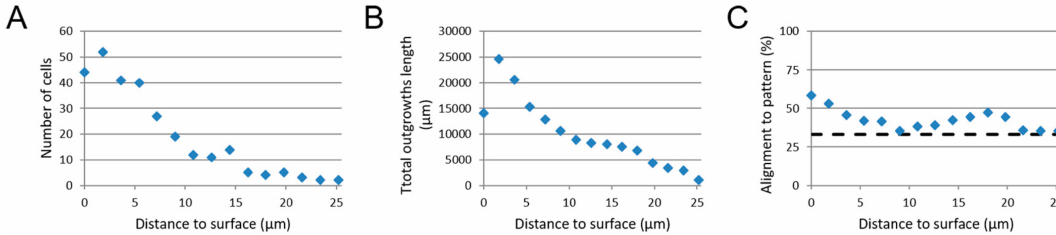
Figure 7. Results from analysis of 3D CTX culture on a nanogrooved substrate. ( A ) The number of cells, ( B ) the total outgrowth length ( µ m) and ( C ) outgrowth alignment (%) relative to the distance ( µ m] away from the nanogrooved substrate. The dashed line at 33% alignment in ( C ) represents an isotropic distribution of outgrowths without preferred direction.